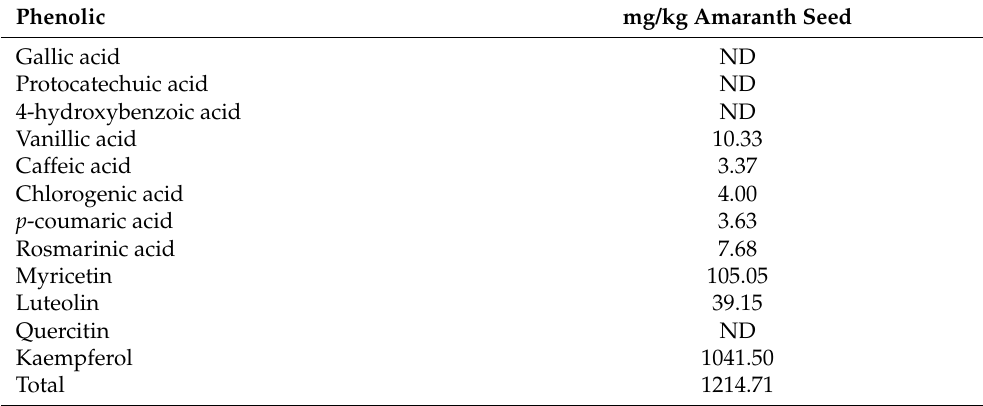
Table 3. Phenolic profile of amaranth